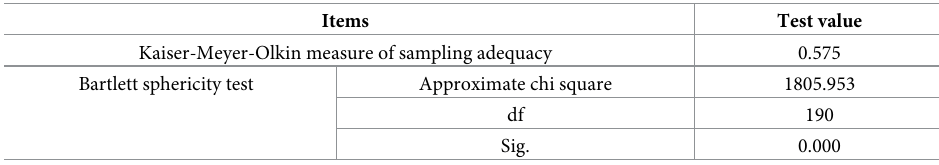
Table 3. Test table of KMO and